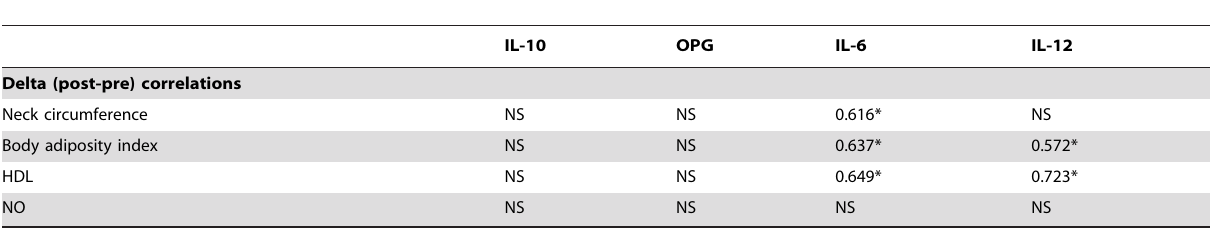
Table 3. Spearman’s correlations between cytokines concentration and anthropometric or biochemical variables.